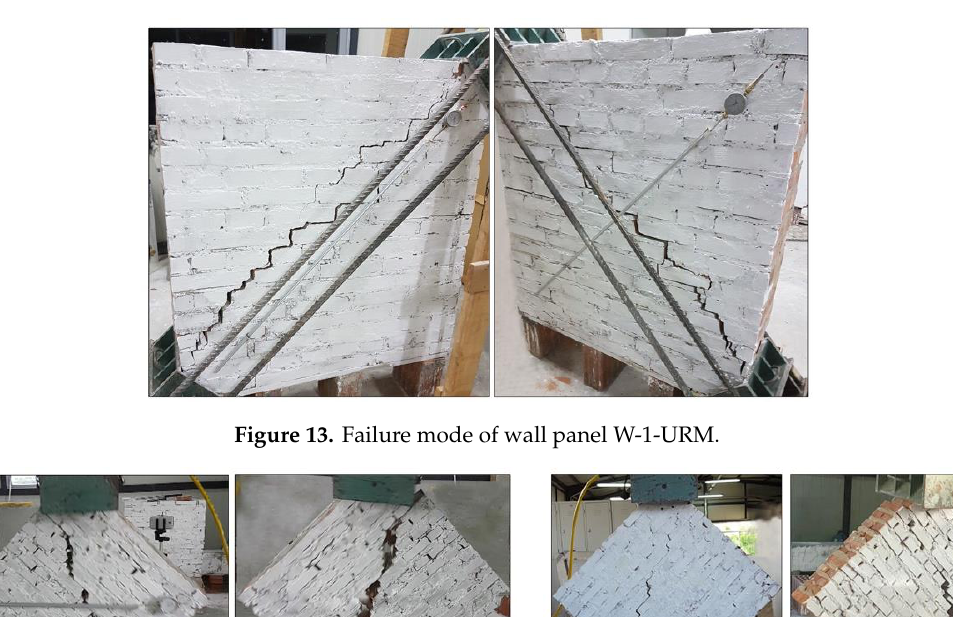
Figure 12. Application of the retrofitting with polypropylene fibers: ( a ) full-scale (W-series) and ( b ) half-scale panel (SW-series).